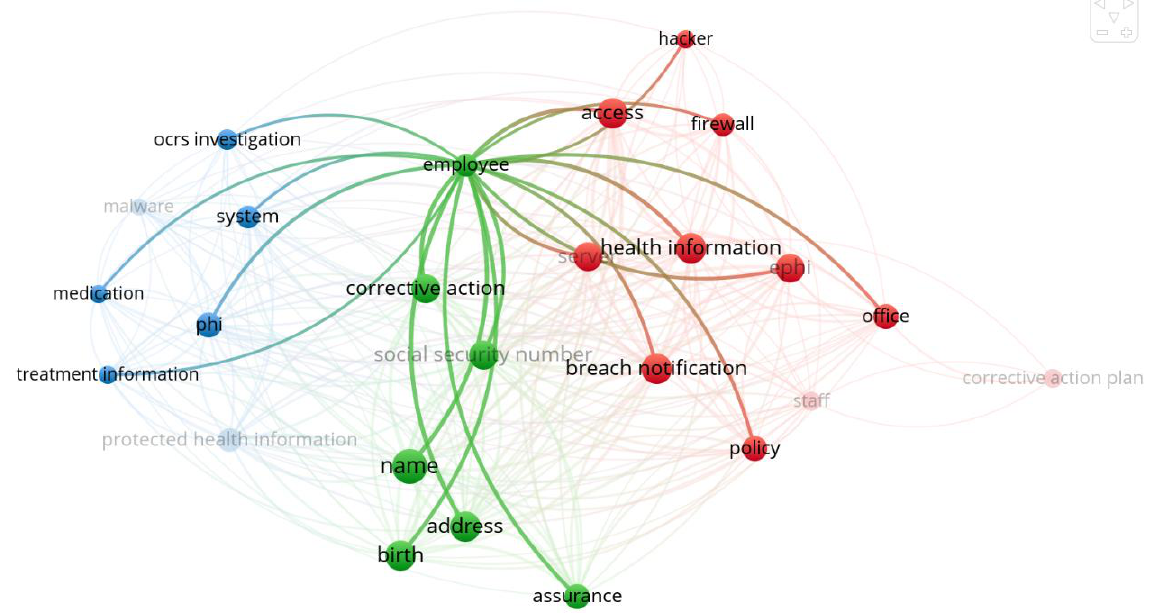
Figure 2. Various Link Strengths of ‘Employee’.